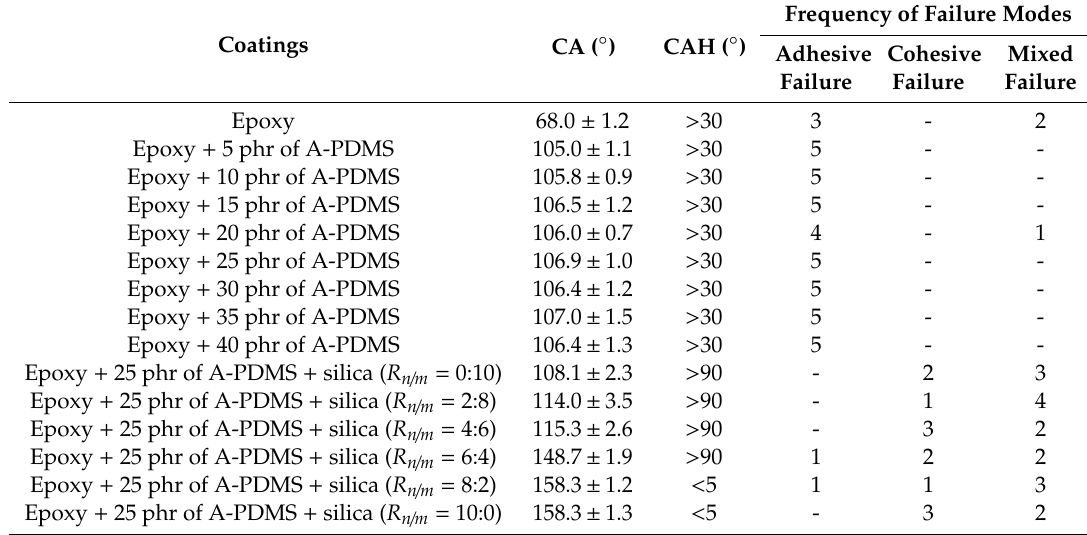
Table 1. Overview of CA (average with ± one standard deviation), CAH and failure modes of various coatings.